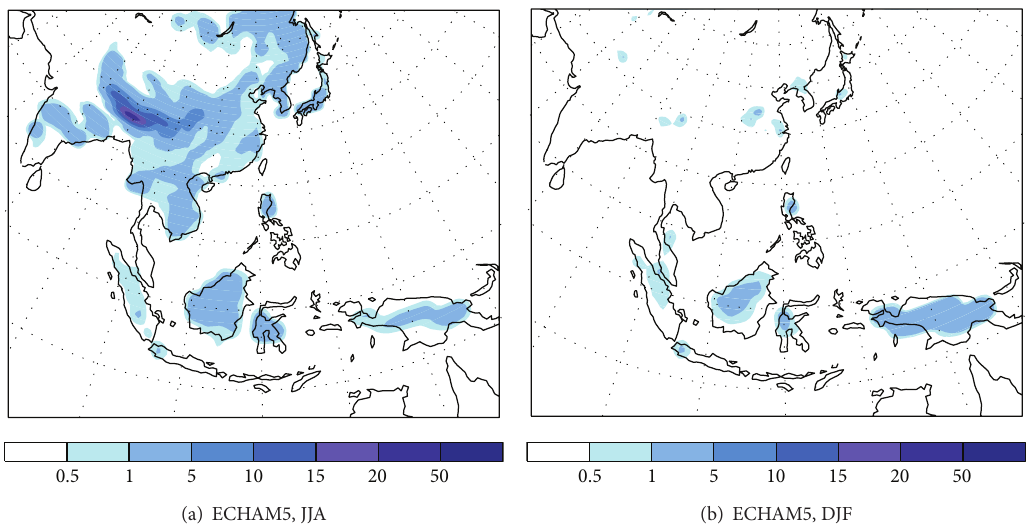
Figure 3: Seasonally averaged runoff (mm d −1 ) obtained from ECHAM5 simulation for (a) JJA and (b) DJF from 1986 to 1995.